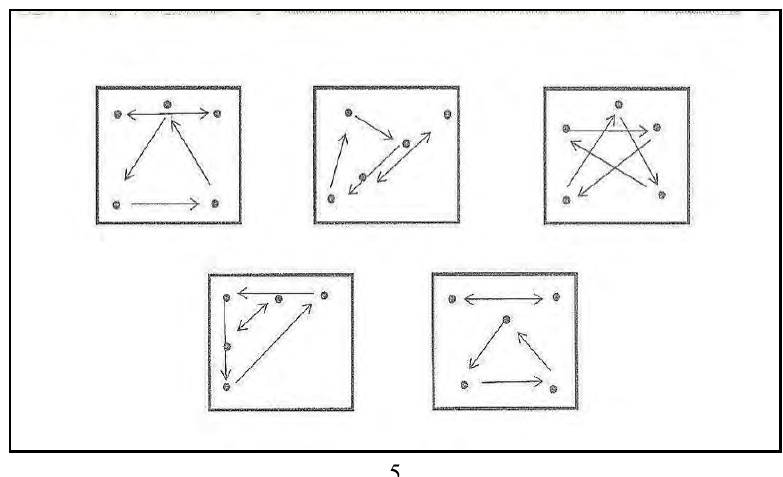
Fig. 4. Positions of female gymnasts (orders) on platform during throws in group exercises with 10 clubs in teams from: 1 – Spain; 2 – Italy; 3 – Byelorussia; 4 – Russian Federation; 5 – Ukraine.